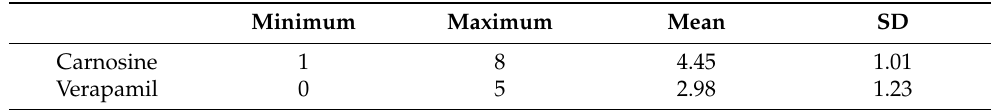
Figure 3. The number of hydrogen bonds (Hbonds) formed between P-glycoprotein (P-gp) and carnosine or verapamil during a 200 ns molecular dynamics simulation. The PDB file 6QEX was selected as a template of P-gp and used for molecular dynamics simulations in the presence of either carnosine or verapamil for 200 ns using the Desmond package of Schrödinger, as described in further detail in Section 4. Table 2. Summary of hydrogen bond statistics of the interaction between carnosine or verapamil with